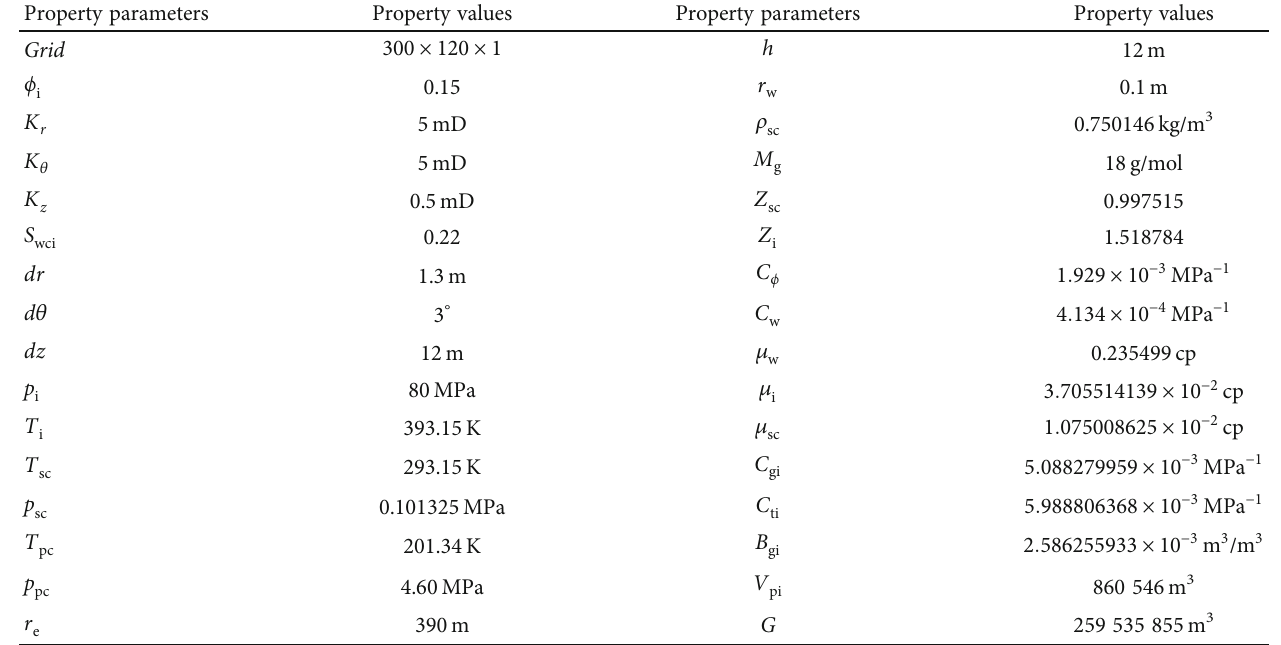
Table 4: Reservoir and gas properties for numerical cases with high pressure.